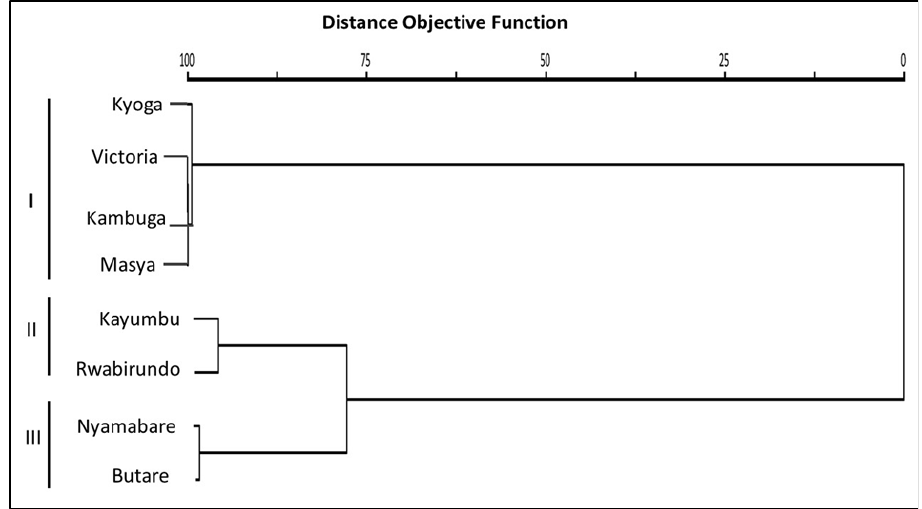
Figure 8. Cluster dendogram of the O. niloticus populations. I. II and III are the clusters generated from the O. niloticus populations in the different sites.